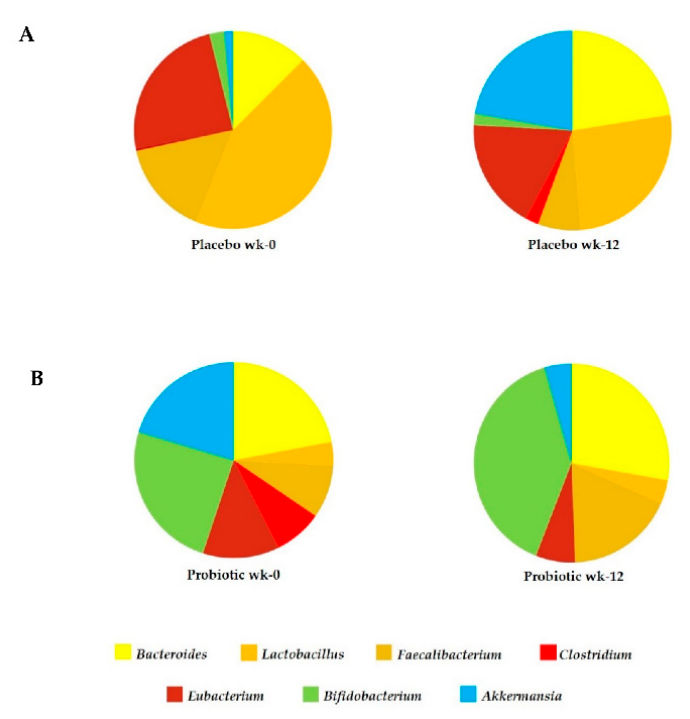
Figure 2. Seven genera: Akkermansia , Bifidobacterium , Eubacterium , Clostridium , Faecalibacterium , Lactobacillus , and Bacteroides dominated the majority of OTUs. 16S rRNA gene sequences were used for identification. The relative abundance of bacteria in feces of placebo group ( A ) and probiotic group ( B ) at baseline and at the end of the study.